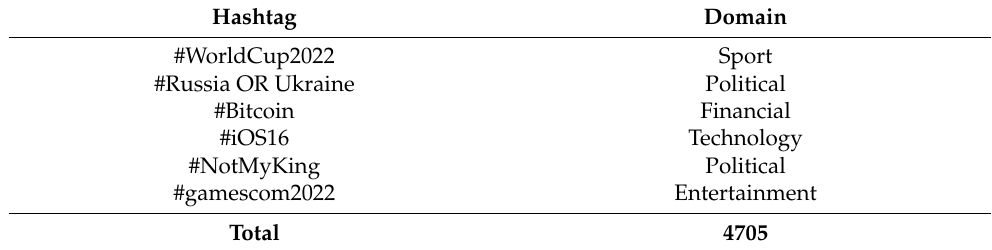
Table 1. Group 1 hashtags.